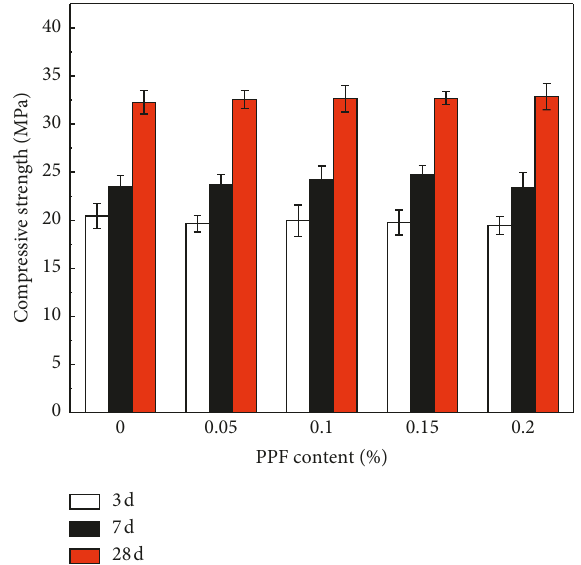
Figure 6: Evolution of the compressive strength of AAS mortars as function of PPF content. The error bars represent the standard deviation of three test specimens.